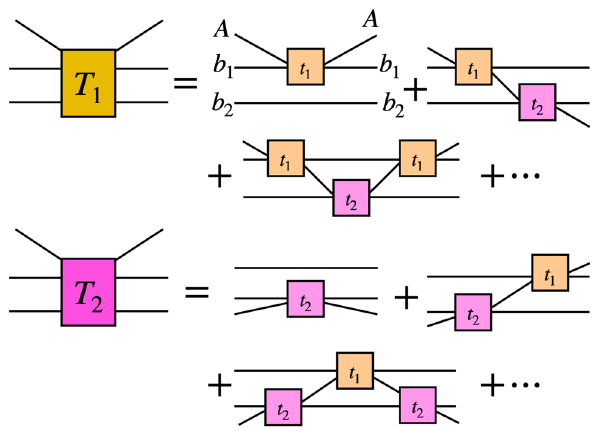
Fig. 1 Diagrams contributing to T 1 and T